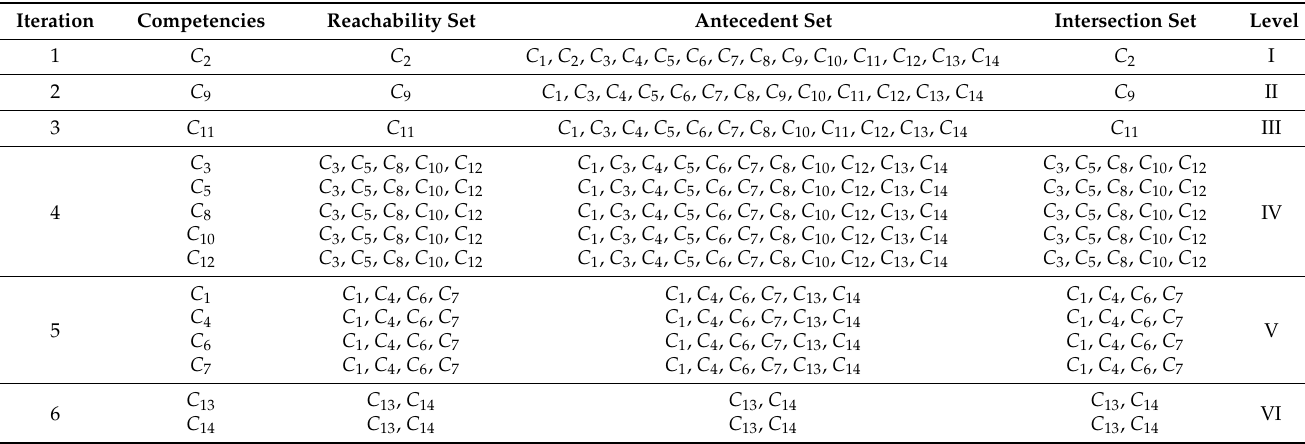
Table 6. Summary of the Partitioning Matrix (PM) of critical Systems-Thinking-based leadership competencies as enablers to better construction safety